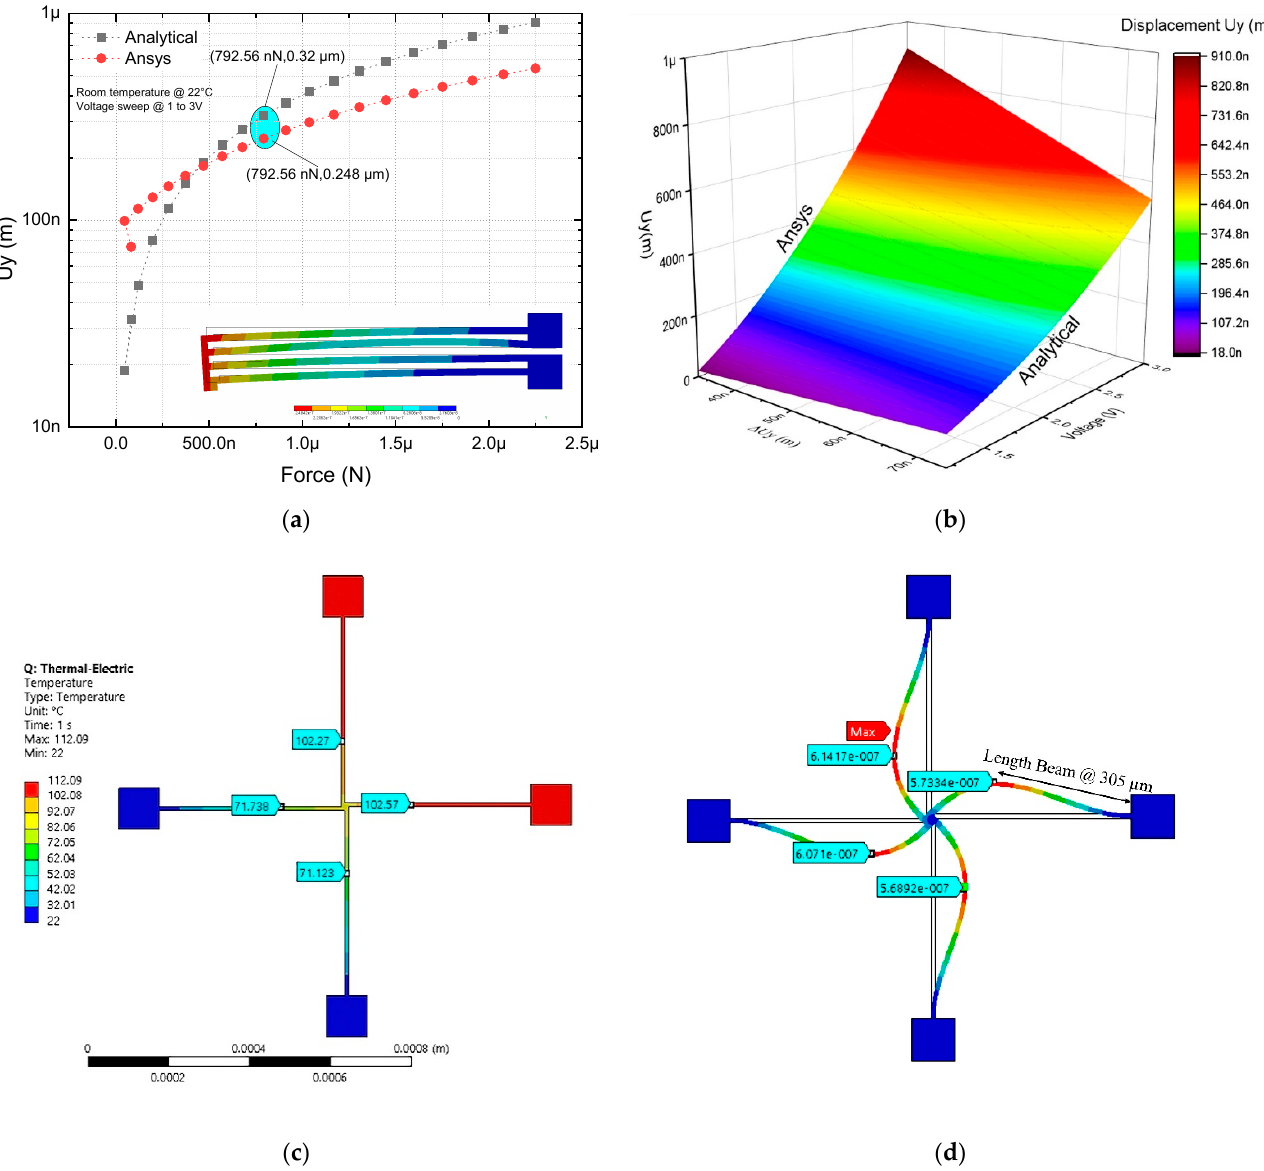
Figure 8. Comparison of analytical and numerical modeling of microactuator with four beams: ( a ) 2D, values of force and displacement at 2V are marked with the blue oval marker, and ( b ) 3D under a voltage sweep from 0 V up to 3 V. ( c , d ) Results of temperature and displacement of the rotary microactuator at 2 V, respectively.